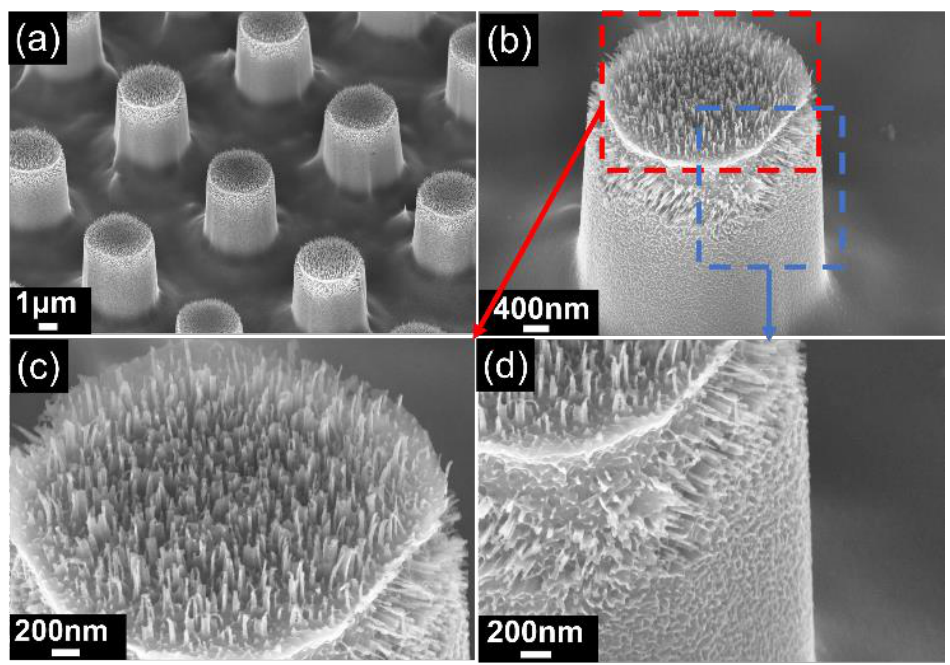
Figure 5. SEM image of the hierarchical micro-/nanostructured surface. ( a ) The hierarchical micro- /nanostructured surface. ( b – d ) The distribution of nanowires on the top surface and side wall of the micropillar.